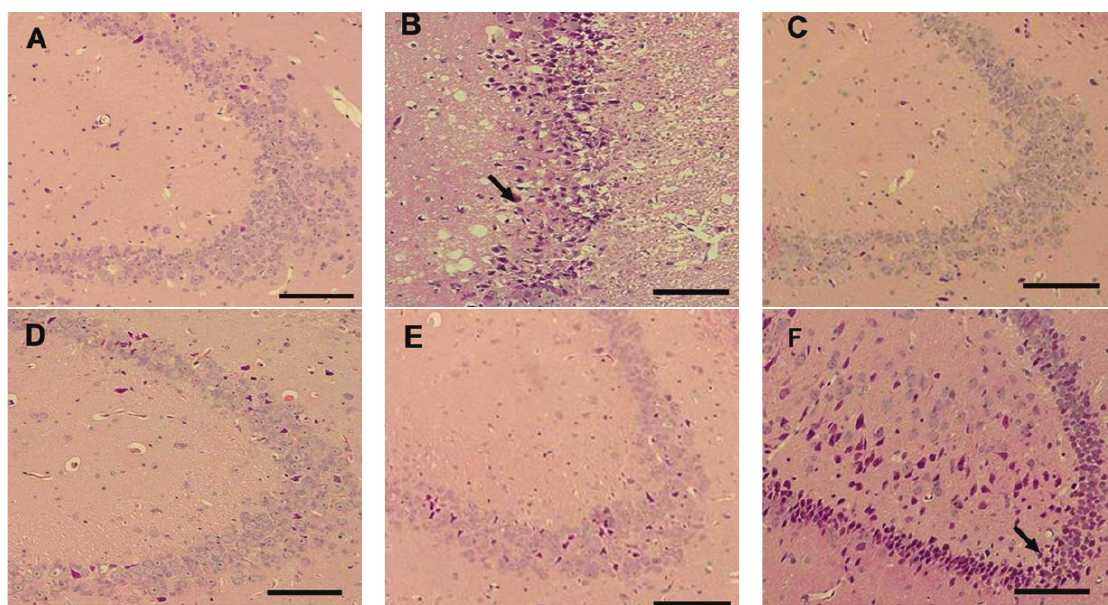
Figure 11: Hematoxylin-eosin. The Neuro-EPO protects the dorsal hippocampal CA3 sector in the focal ischemia model, (C, D, E). Bar 100 µ m A: dorsal hippocampal CA3 sector in control. B: Arrows withdrawn neurons with pyknotic nuclei and eosinophilic cytoplasm animals treated with vehicle. C, D, E: dorsal hippocampal CA3 without injury starting treatment with Neuro-EPO intranasal at immediately, 6 hours at 12 hours, respectively. F: Dorsal hippocampal CA3 sector starting treatment at 18 hours. Arrows withdrawn neurons with pyknotic nuclei and eosinophilic